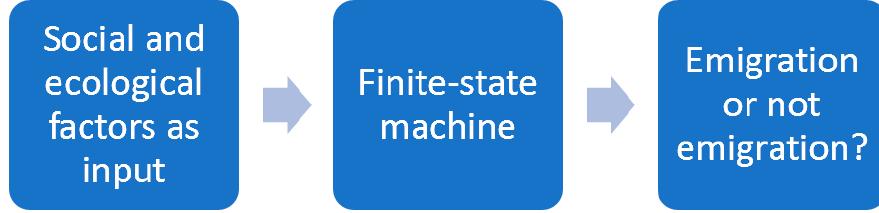
Figure 4. The first research question.